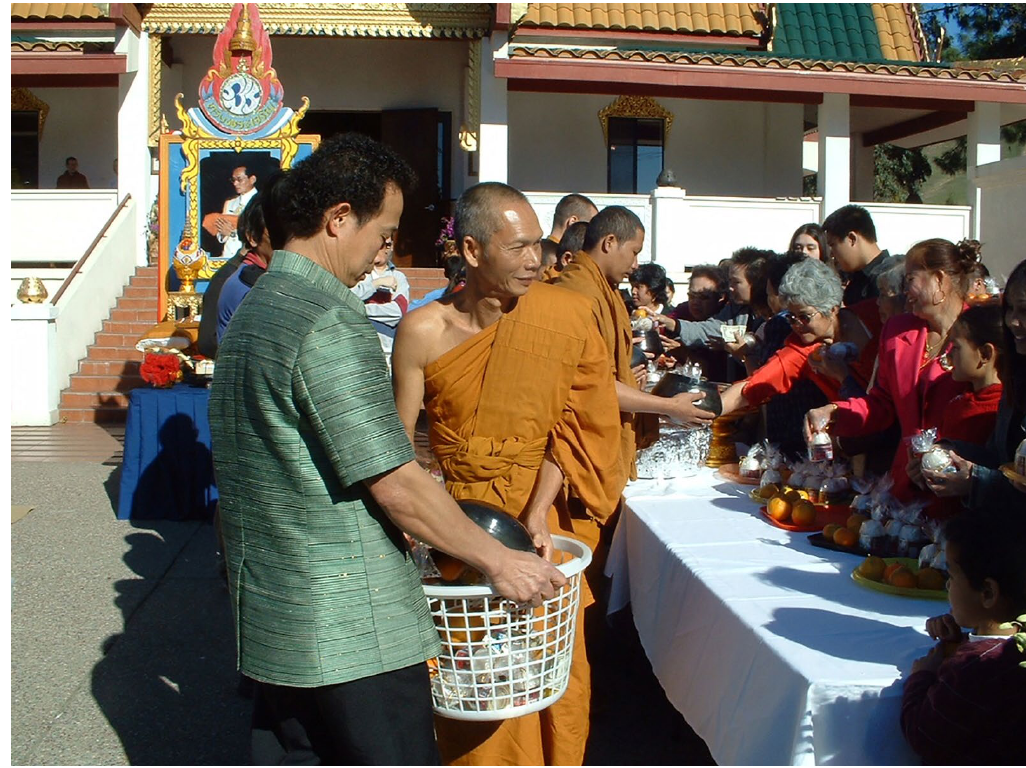
Figure 3: Offering and receiving alms at a community event (photograph by the author, 2004) Giving and receiving alms food is informed by a reciprocal relationship (Kieschnick 2003; Lopez 2001; Spiro 1966; Tambiah 1970). Offering alms is perceived as a way to